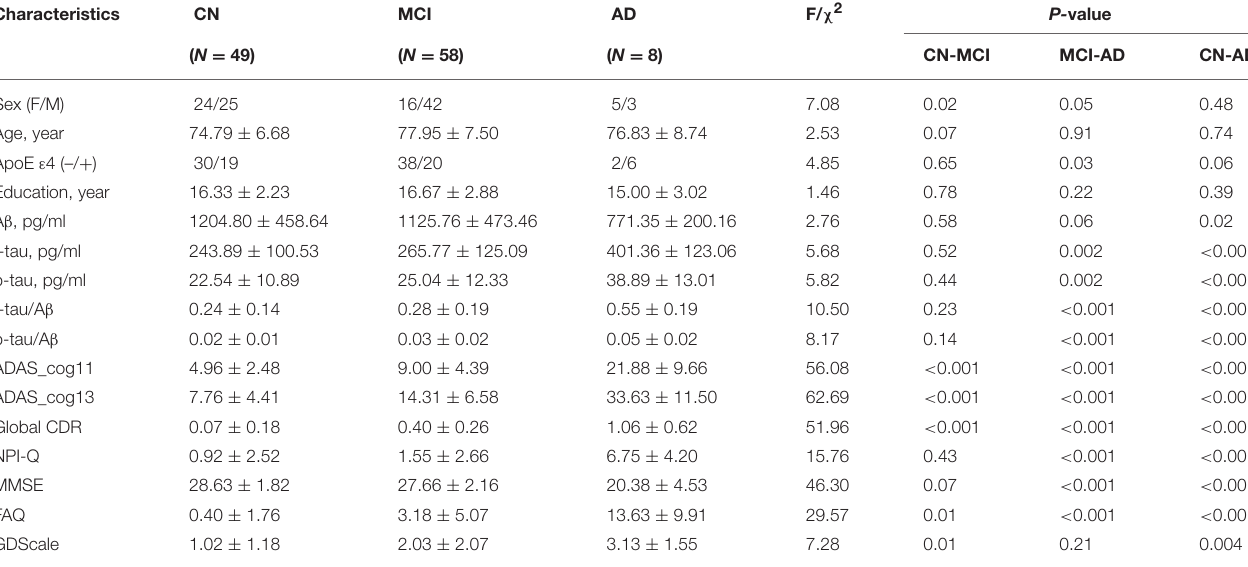
TABLE 1 | Demographics and clinical